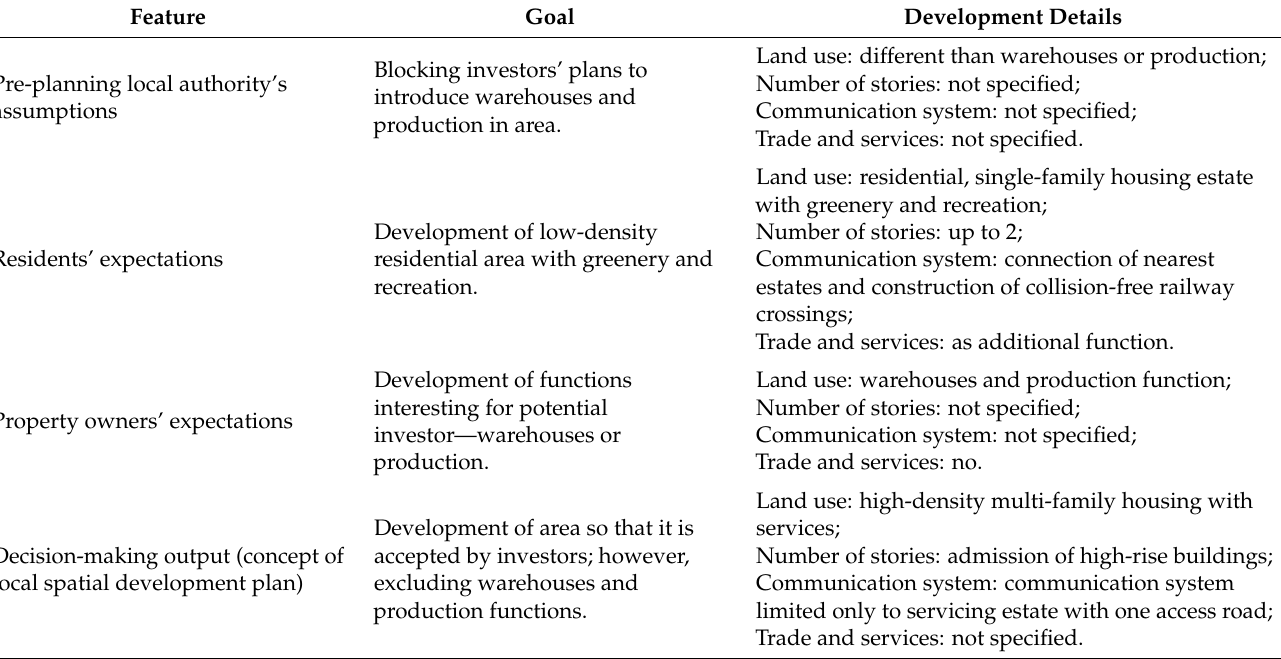
Table 5. The vision of the development of the New Center of Rokietnica according to the expectations of various stakeholders. Feature Goal Development